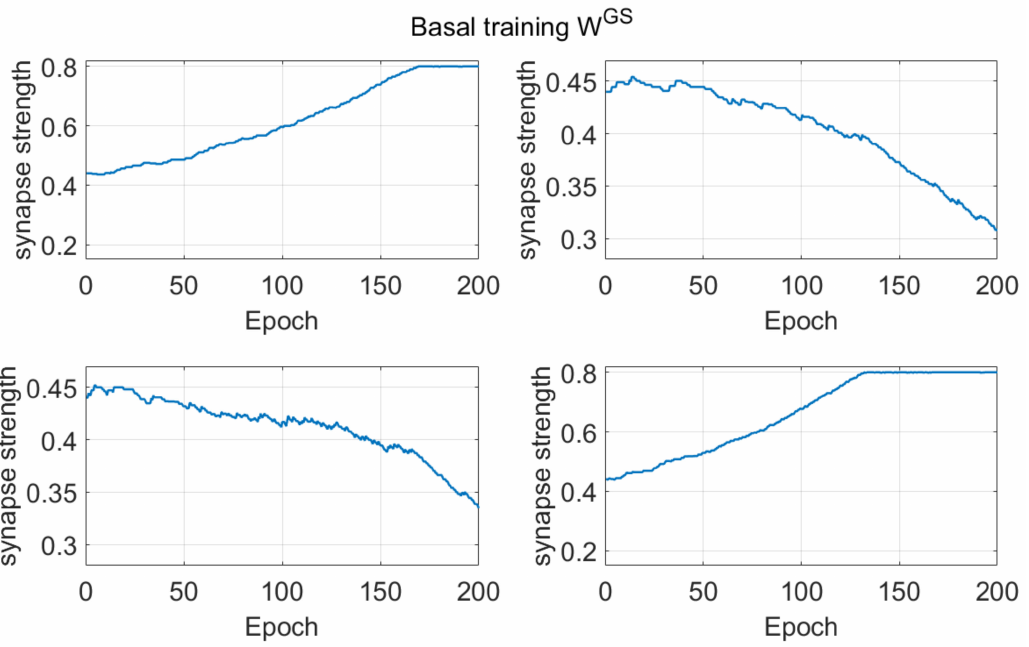
Figure 3. Effect of training on the sensory synapses. The figure shows the temporal pattern of the synapses, which connect the external stimulus S to the Go neurons, as a function of the training epoch (rule post-post). Since we used two action channels, and a 2 × 1 stimulus vector, the synapse array has the dimensions 2 × 2. The first line represents the two synapses entering into the Go neuron in the first channel from the two input stimuli. The second row represents the two synapses entering into the Go neuron of the second channel, from the same input stimuli. By increasing synapses in the principal diagonal, and decreasing those in the secondary diagonal, the network recognizes that a high value of the first stimulus is especially associated with a first-action reward, whereas a high value of the second stimulus more often rewards the second